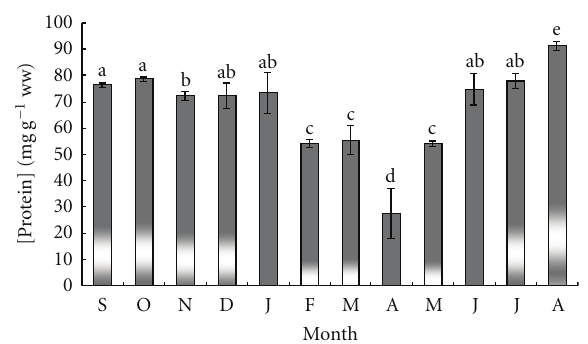
Figure 2: Monthly variation of protein levels in sea urchin gonads. Columns with the same letter are not significantly di ff erent.